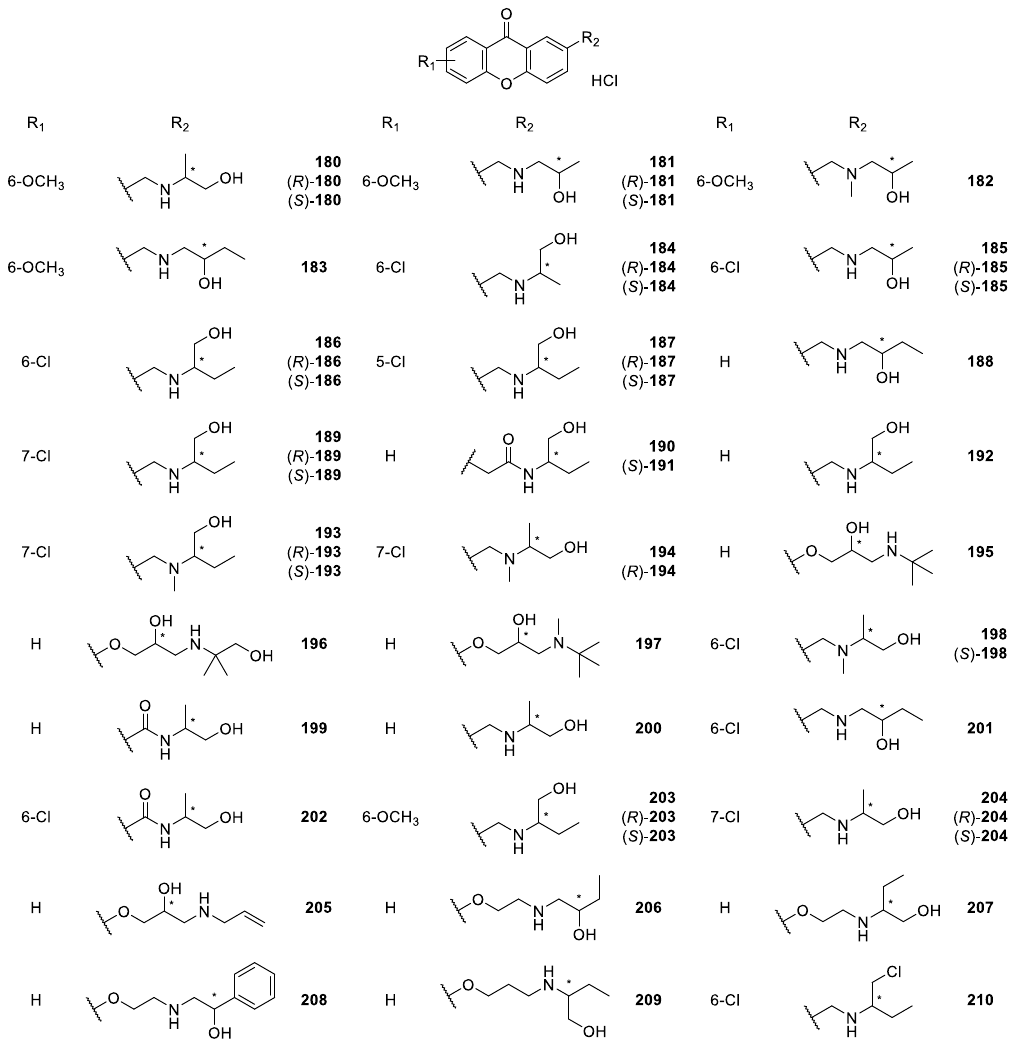
Figure 18. Structures of 2-aminoalkanolic CDXs 180 – 210 .